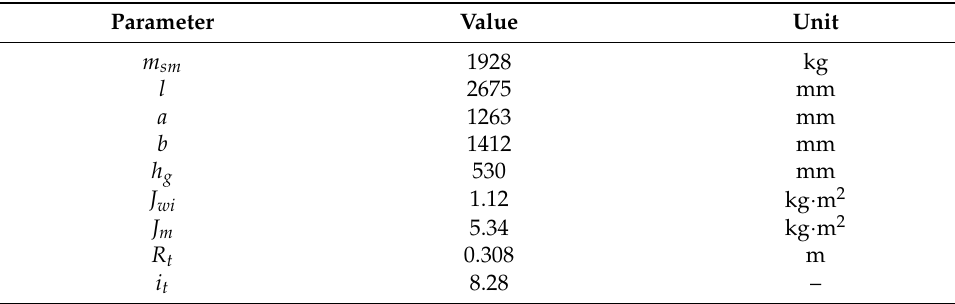
Figure 3. The reference vehicle force analysis curve.